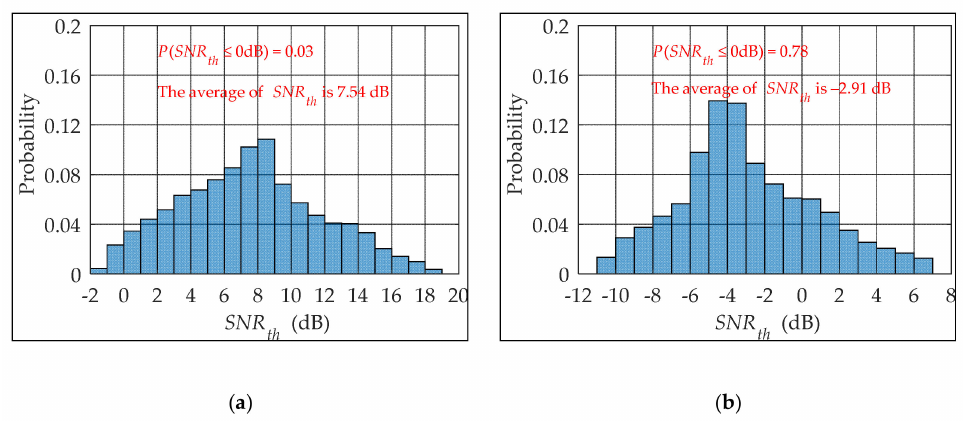
Figure 9. Statistical histograms of SNR th : ( a ) EPD–MD method; ( b ) EC–PD method.